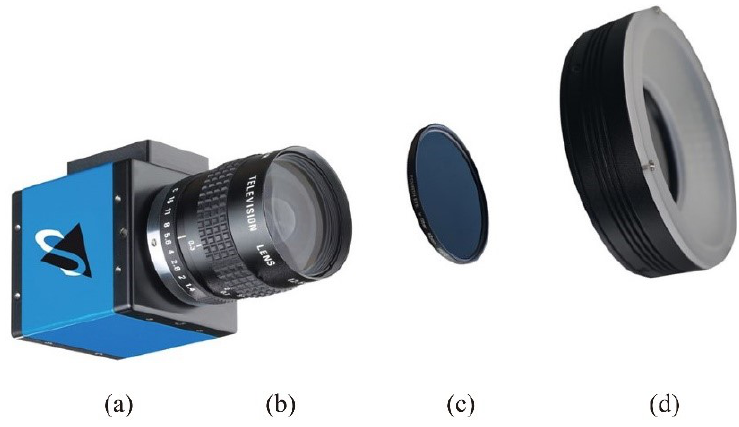
Figure 3. Schematic diagram of the relative position of camera, filter, and ring light source. ( a ) The imaging source, ( b ) the industrial lens, ( c ) 850 nm infrared filter, and ( d ) 850 nm ring light source.